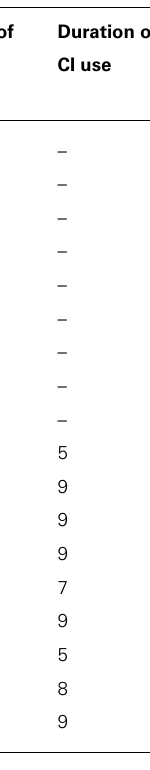
Table 1 | Clinical profile of the deaf